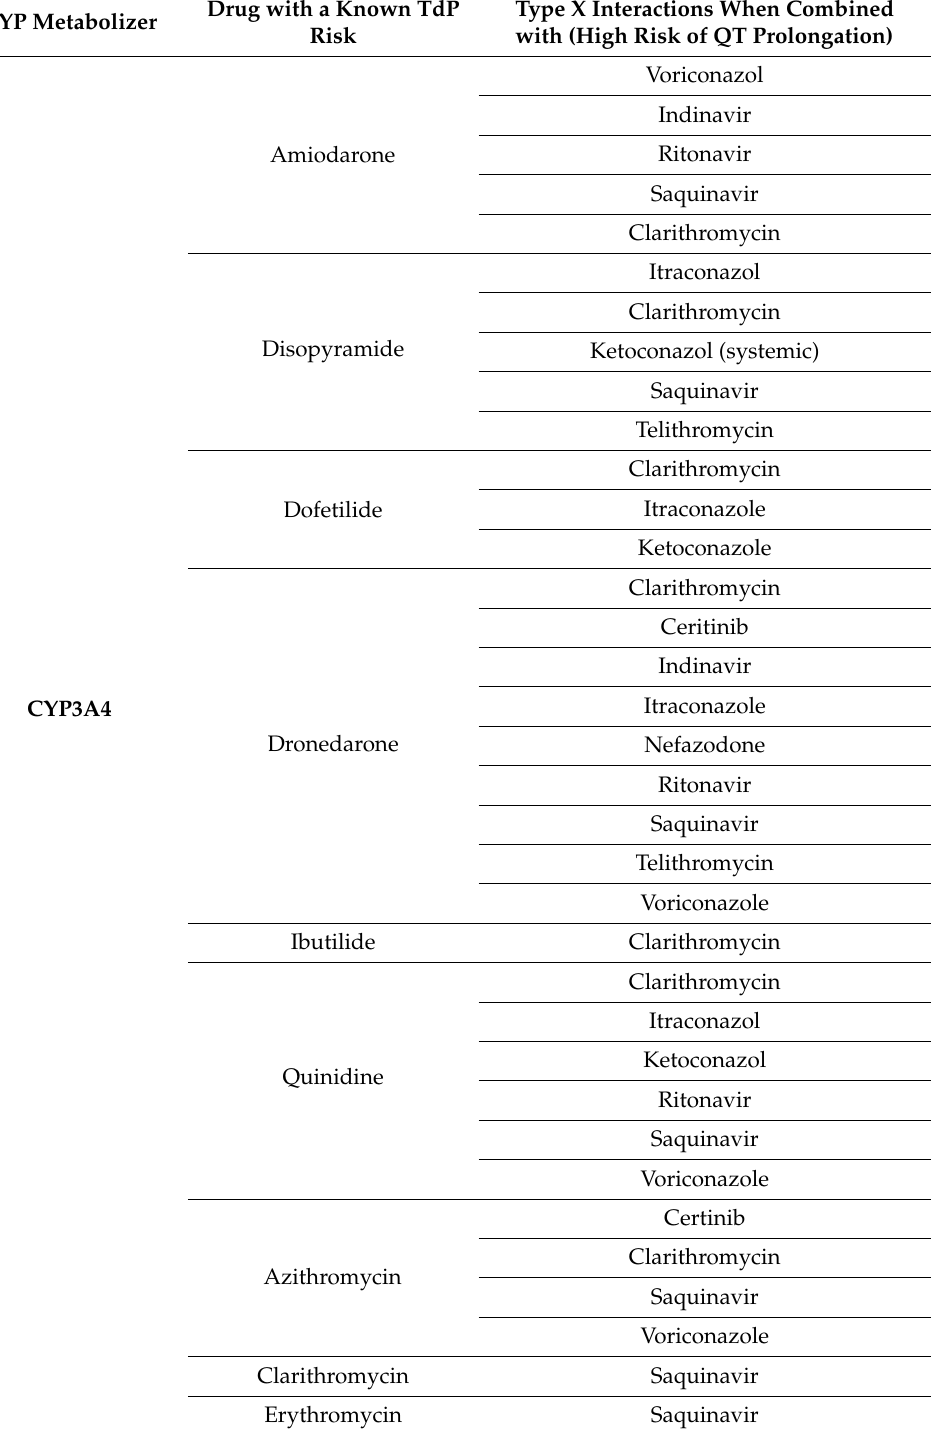
Table 4. Known high TdP risk drugs and CYP strong inhibitors